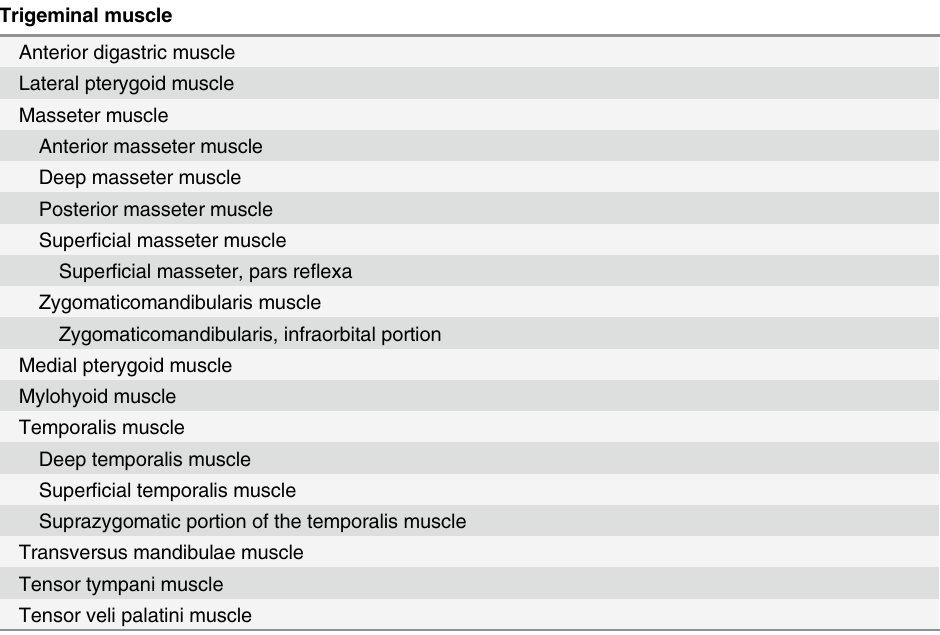
Table 2. Classes returned by the MFMO from a DL Query in Protégé for muscles that develop from the first branchial